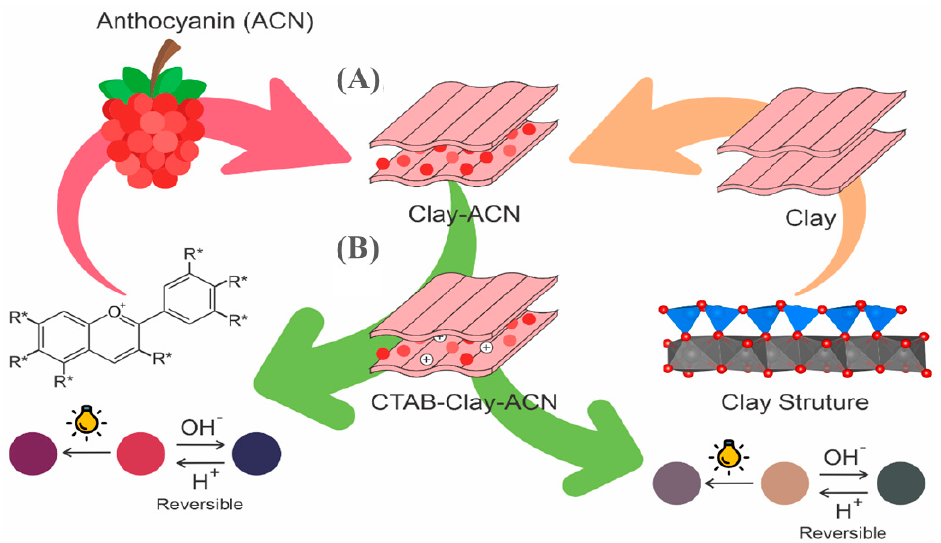
Figure 4. ( A ) Incorporation of anthocyanin in the surfactant–clay mineral ( B ) Stability of anthocyanin Figure 4. (A ) Incorporation of anthocyanin in the surfactant–clay mineral ( B )Stability of anthocya- nin in the surfactant–clay mineral–anthocyanin hybrid under visible light. in the surfactant–clay mineral–anthocyanin hybrid under visible In another study, hybrid pigments [44] based on saponite, cetrimonium bromide (CTAB), and anthocyanin extracted from grape juice and adding β -cyclodextrin ( β -CD) were synthesized. Saponite was provided at the LAMS laboratory in France. The study showed the formation of complexes between β -cyclodextrin ( β -CD) and cetyltrime- thylammonium bromide (CTAB), intercalated in the interlayer spaces of saponite (SAP), with the interaction of anthocyanin Crystal Red Grape (RG), resulting in the com- pounds: (CTAB_SAP-RG; β -CD_SAP-RG and β -CD + CTAB_SAP-RG). Both studies, an-